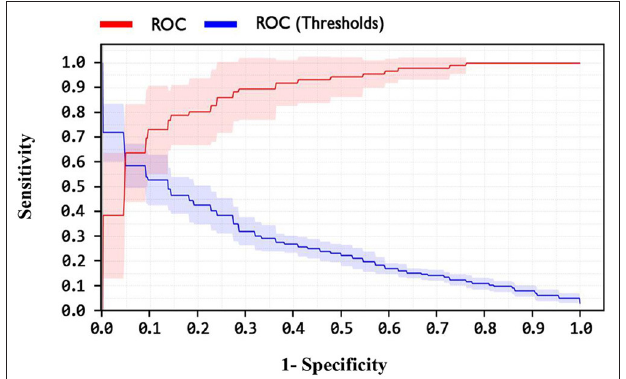
FIGURE 11 | ROC curve for SVM with ANOVA method.